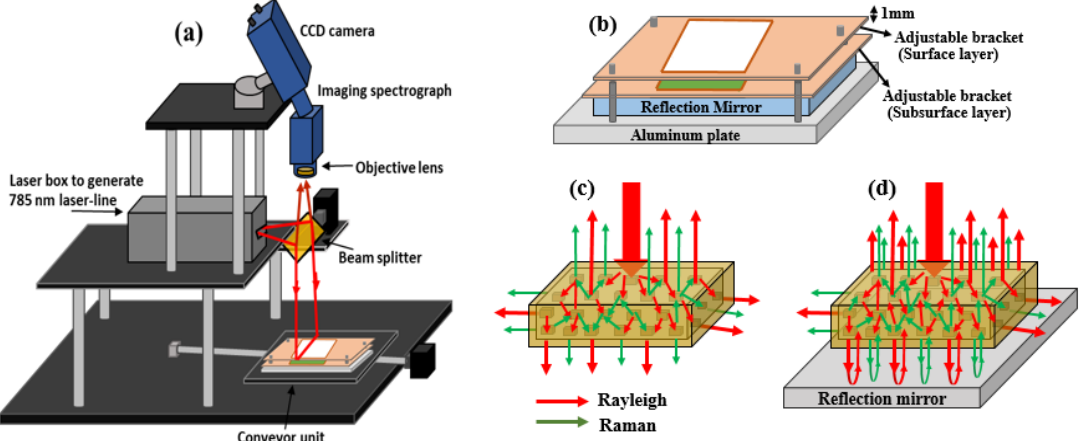
Figure 1. Schematic diagram of line-scan Raman imaging system ( a ), sample holder with reflection mirror to facilitate layered samples ( b ), and schematic representation of Raman signals collated without ( c ) and with a back-reflection mirror ( d ).